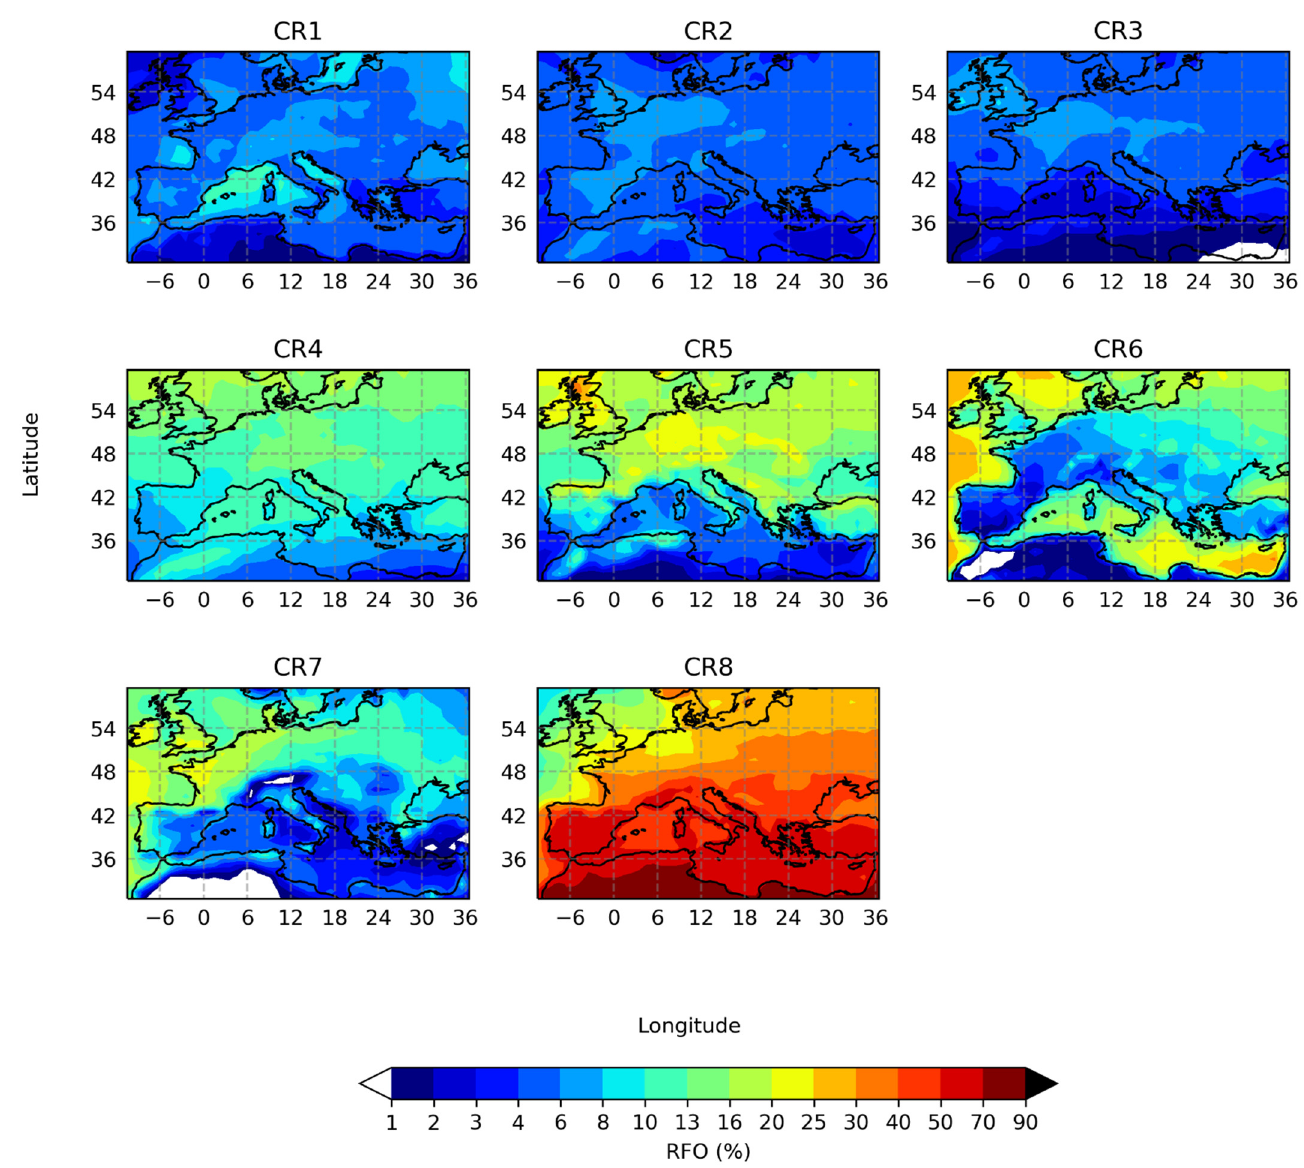
Figure 2. Geographical distribution of the overall mean relative frequency of occurrence (RFO) of the 8 CRAAS cloud regimes (CRs). Table 1. Summary of the 8 CRAAS cloud regimes (CRs) including the mean properties and the main cloud types associated to each of the cloud regimes.